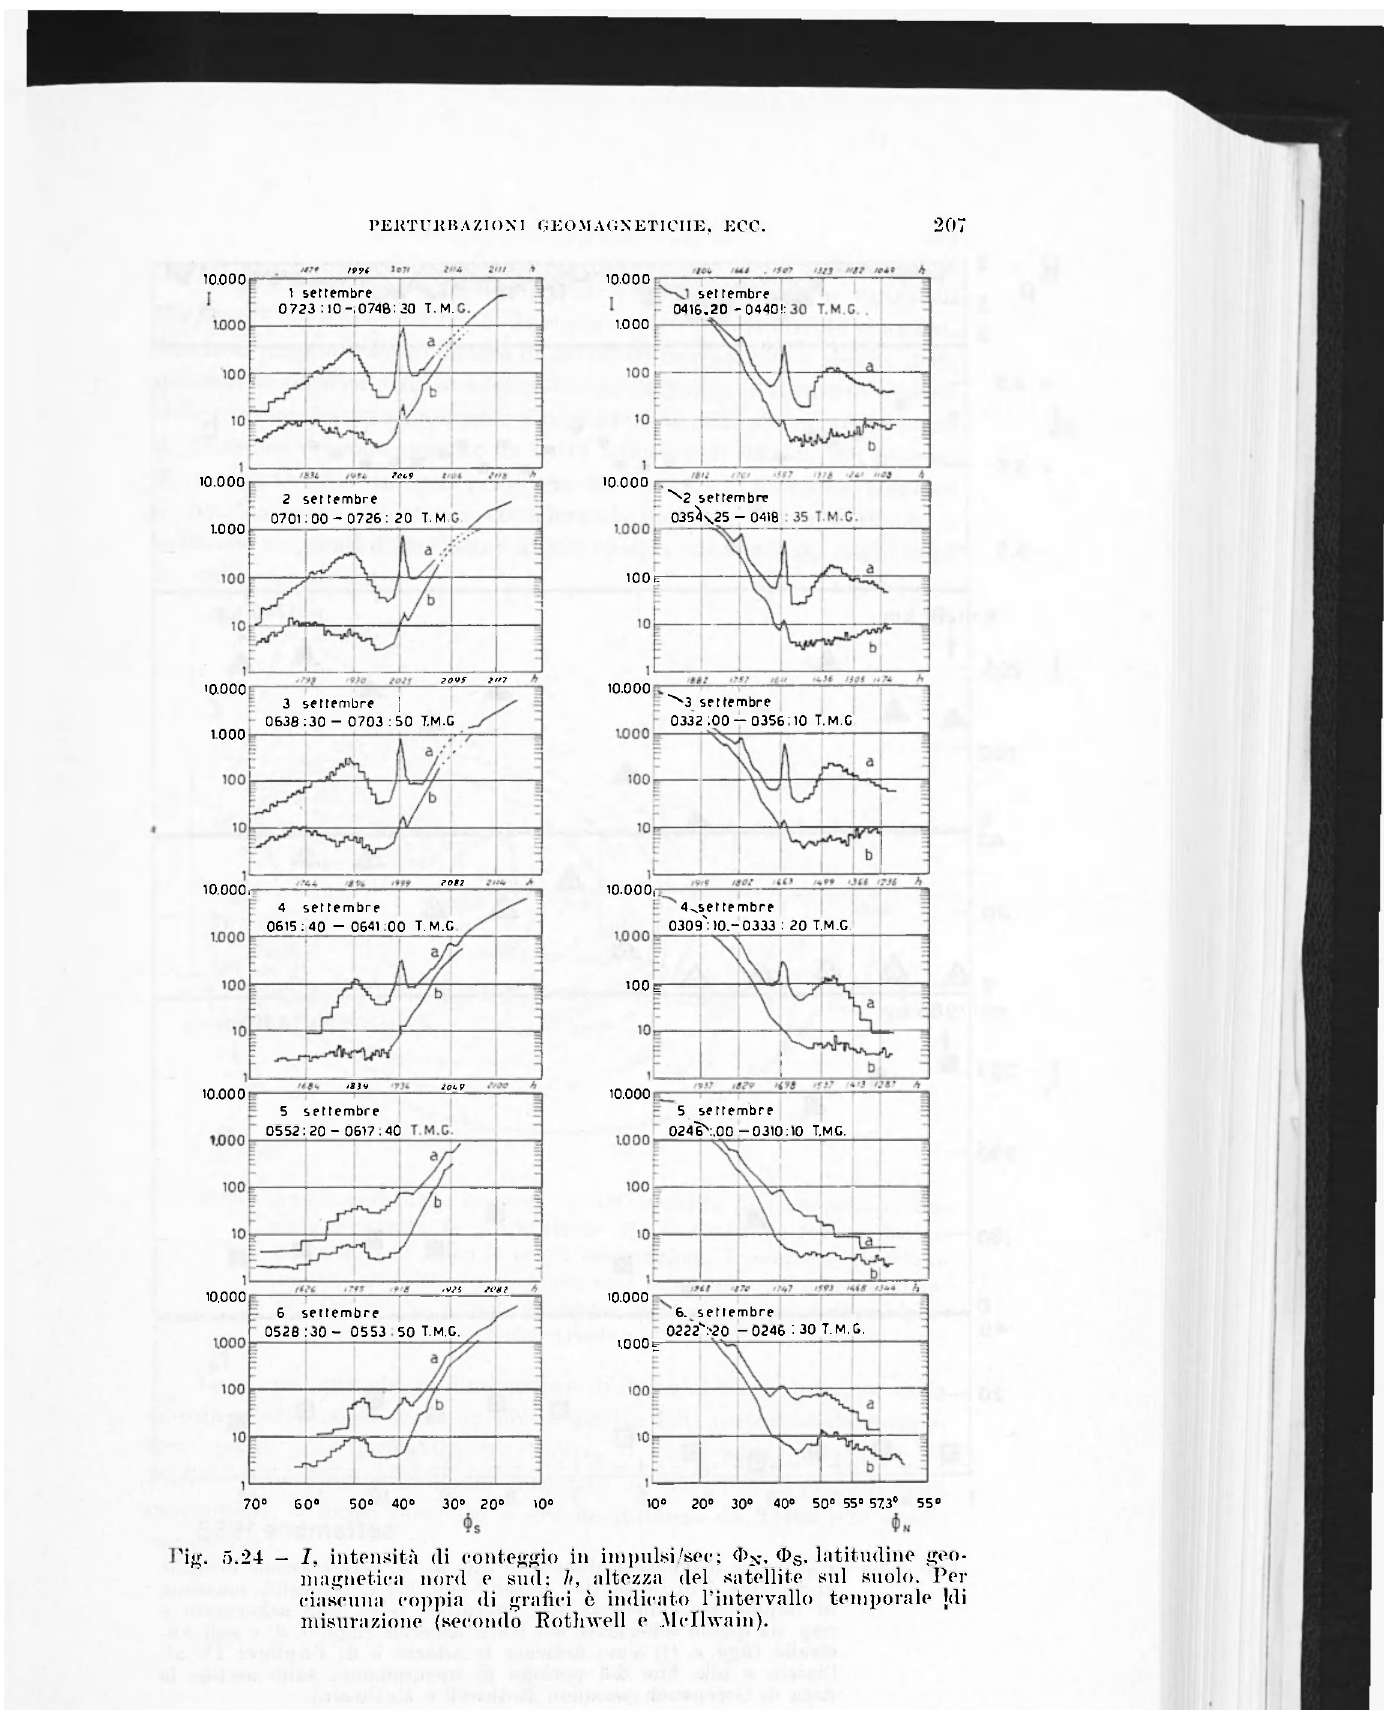
Mg. 5.24 - I, intensità di conteggio in impulsi/sec; O n , <l' s . latitudine geo- magnetica nord e sud; h, altezza del satellite sul suolo. Per ciascuna coppia di grafici è indicato l'intervallo temporale [di misurazione (secondo Rothwell e